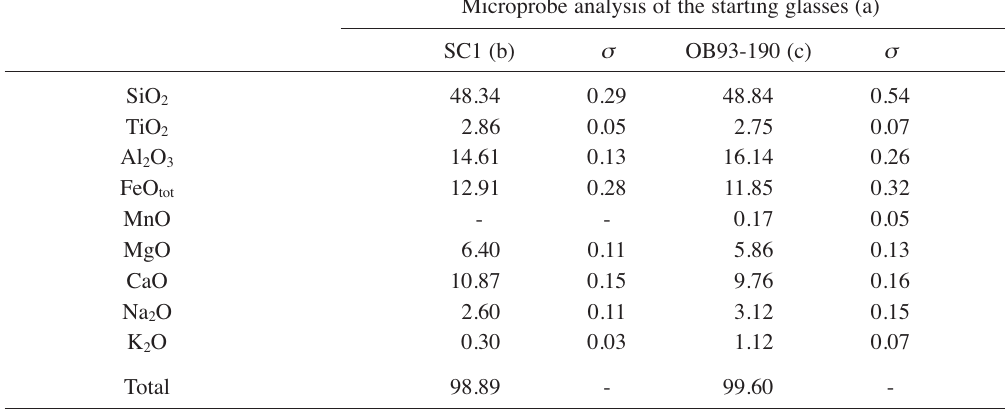
Microprobe analysis of the starting glasses